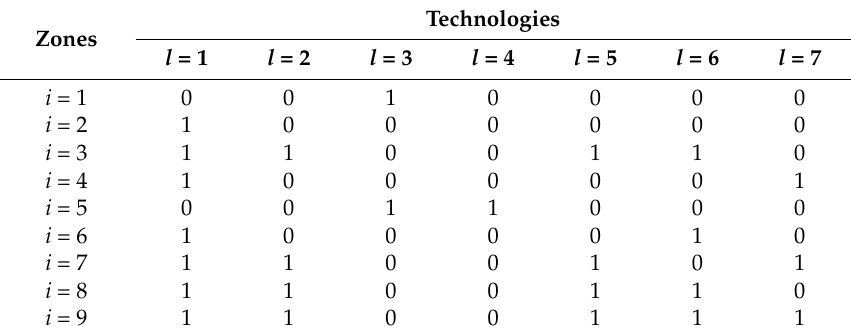
Table 4. Ecological technologies for carrying capacity improvement in the Yitong River.